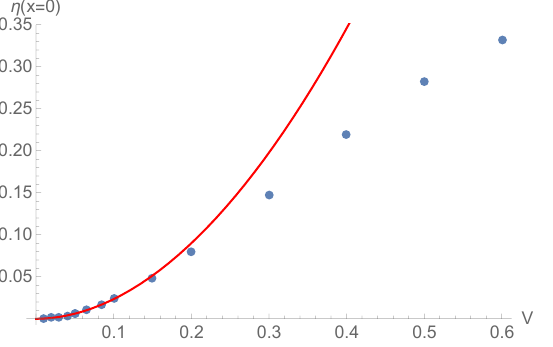
Figure 7 . Dependence of the suppression of the peak of the vev, (cid:17) , de(cid:12)ned in (4.5), as a function of disorder. The solid red line is a (cid:12)t we do for small (cid:22) V , obtaining (cid:17) ( x = 0) (cid:25) a (cid:22) V (cid:13) with a = 2 : 05, (cid:13) = 1 : 94. At higher (cid:22) V the exponent of the power law decreases.